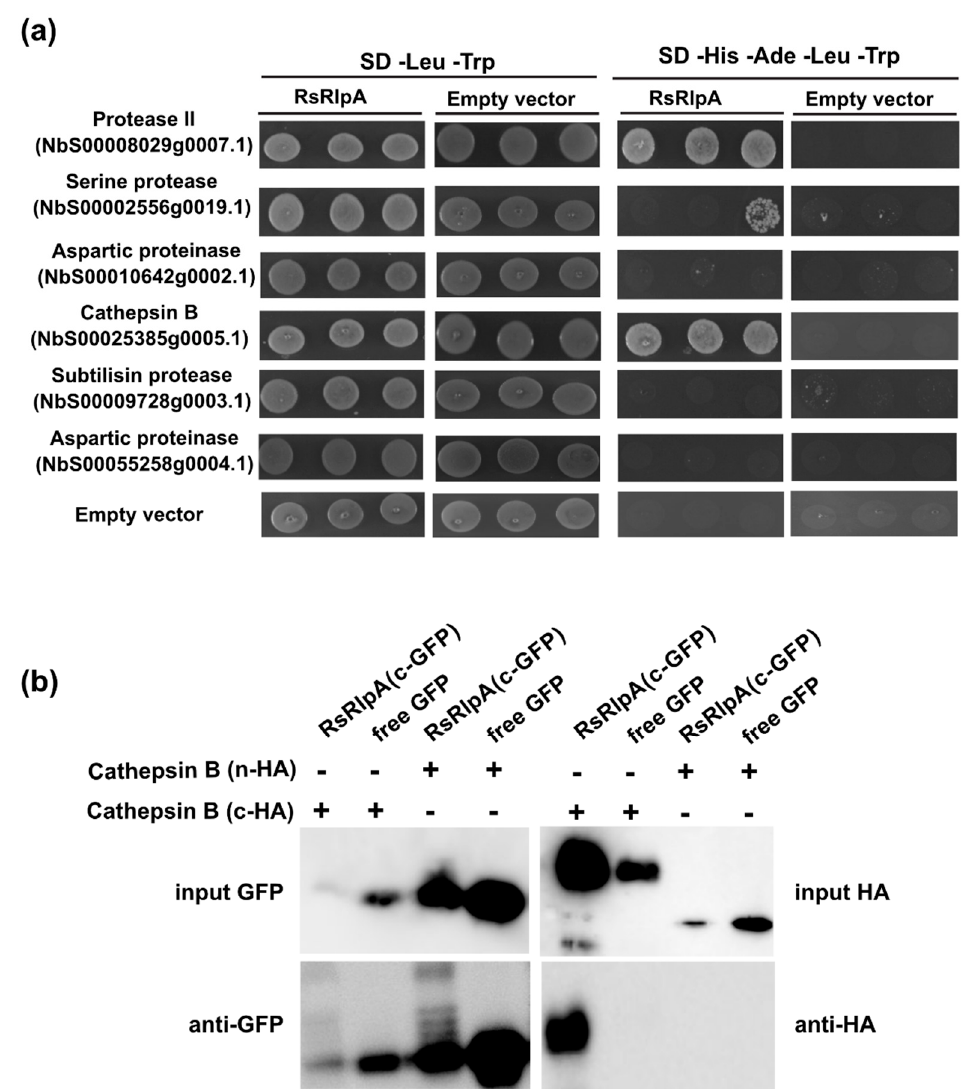
Figure 6. The RsRplA interacts with a plant cathepsin. ( a ) Pairwise yeast-two-hybrid analysis between RsRlpA (used as a prey in pGADT7 vector) and potentially interacting plant proteases (used as baits in pGBKT7 vector). Growth of yeast cells on SD-4 (-His, -Ade, -Leu, -Trp) selective media represents protein–protein interaction and growth on SD-2 (-Leu, -Trp) media confirms yeast transformation. Yeasts transformed with the empty vectors were used as negative controls. ( b ) Co-immunoprecipitation (co-IP) assay between the GFP-tagged RsRlpA and HA-tagged cathepsin, transiently co-expressed in N. benthamiana and pull-downed using the GFP-trap agarose magnetic beads.